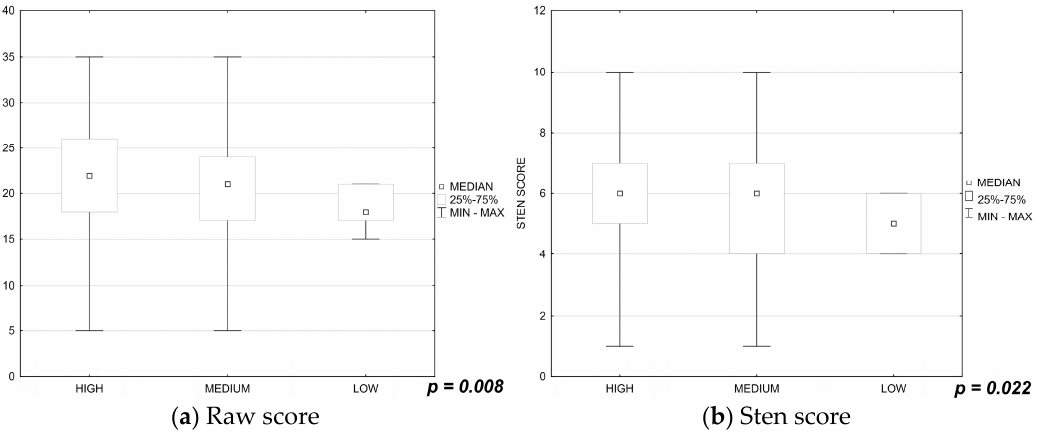
Figure 4. ( a , b ) Influence of the nurses’ self-assessed knowledge of SARS-CoV-2 infection on their satisfaction with life.